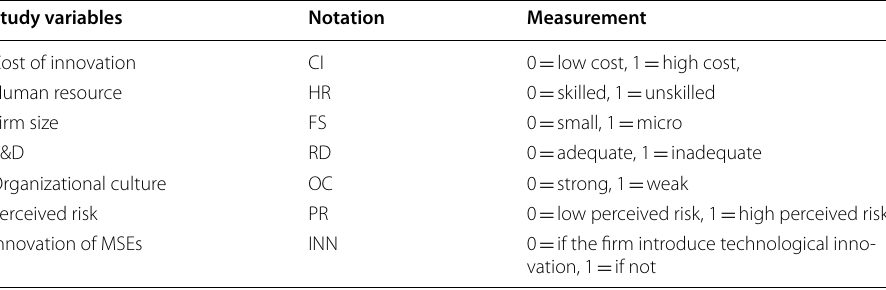
Table 1 Description of the variables in the